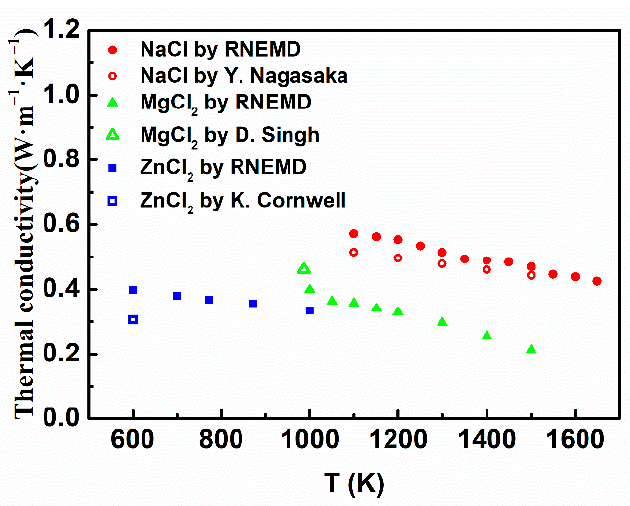
Figure 9. Thermal conductivities of molten chloride salts in different temperatures.